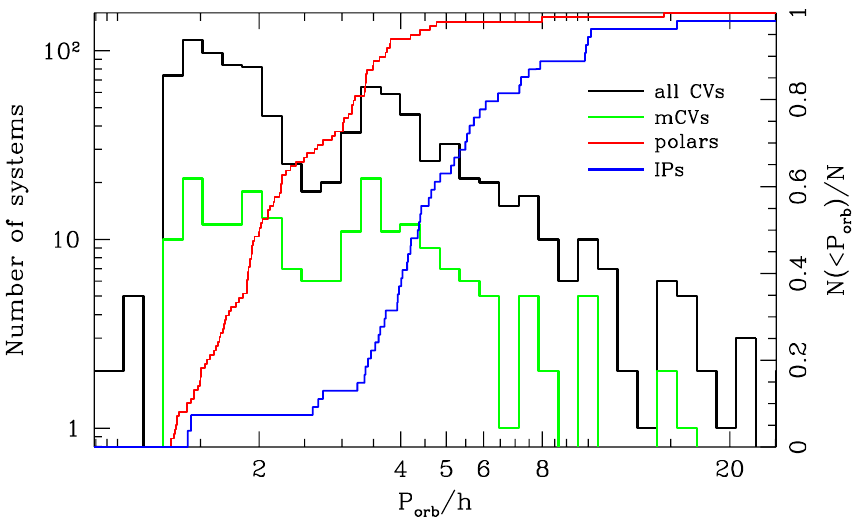
Figure 2: The orbital period distribution of all CVs (black), and mCVs (green). Cumulative distributions are also shown for polars (red) and IPs (blue). Almost all IPs are found at long P orb , while most polars are short- P orb systems. Periods from Ritter & Kolb